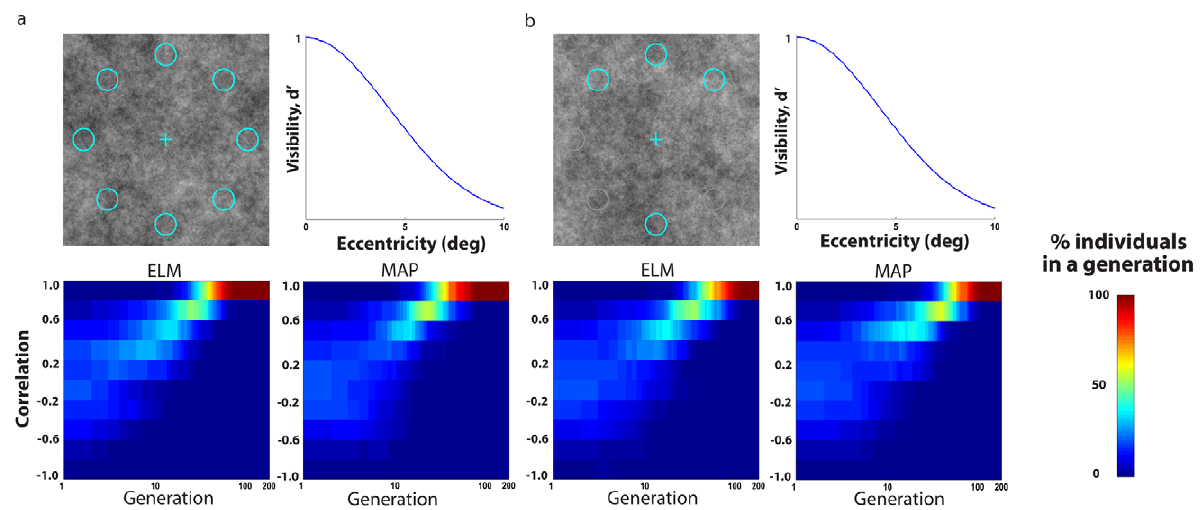
Figure 4. Evolution plots for different models and scenarios detecting the elongated Gaussian target (Figure 2b; middle). a. 8 AFC search with a broad visibility map using 1/f noise for the Entropy Limit Minimization model (ELM) and the Saccade Targeting model (MAP); b. 4 AFC with broad visibility map using 1/f noise for the ELM and MAP model. All results based on averages across 10 virtual evolution runs.